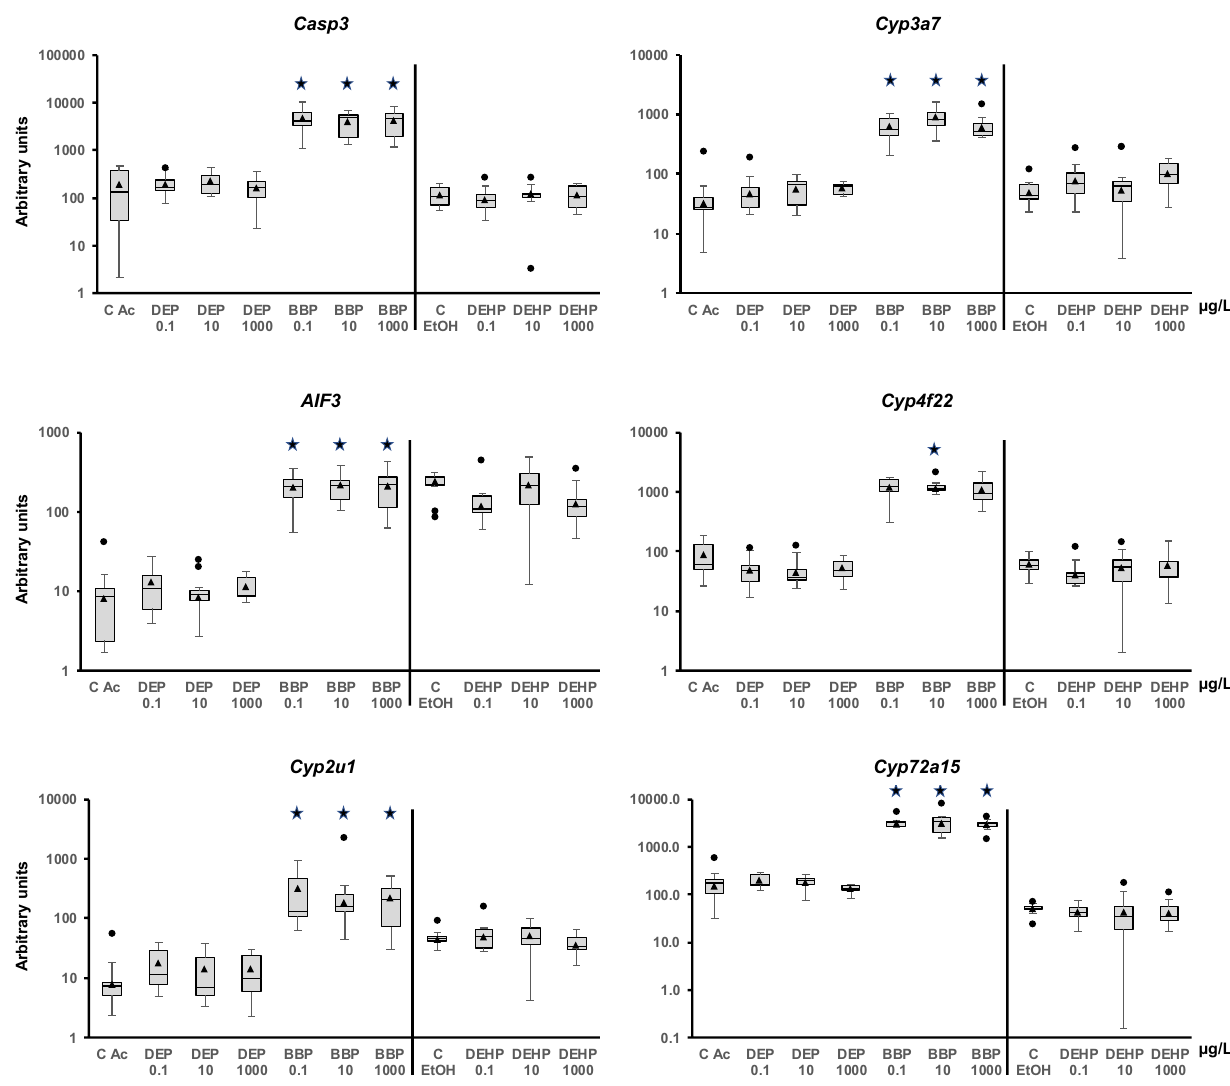
Figure 3. Transcriptional activity of genes related to apoptosis ( Casp3 and AIF3 ) and phase I detoxification ( Cyp2u1 , Cyp3a7 , Cyp4f22 , and Cyp72a15 ) in adult Physella acuta after in vivo exposure to diethyl phthalate (DEP), benzyl butyl phthalate (BBP), and bis-(2-ethylhexyl) phthalate (DEHP) for 1 week at 19 °C. The mRNA levels were normalized using rpL10 , Act , PFKFB2 , and GAPDH as reference genes. The comparison was performed with the solvent-exposed (EtOH, acetone) controls. Whisker boxes are shown (n = 9 individuals per box). The median is indicated by the horizontal line within the box, and the 25th and 75th percentiles are indicated by the boundaries of the box. The highest and lowest results are represented by the whiskers. The small triangle inside the box denotes the mean, and the outliers are shown (circles). Significant differences to the respective controls (asterisk) are indicated ( p <